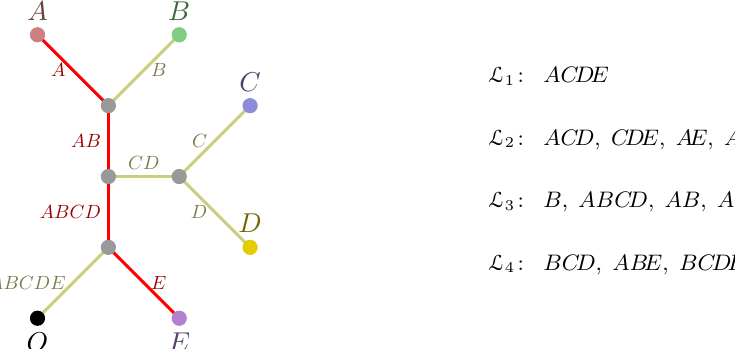
Figure 6. An example of a simple tree with a choice of min-cut for ACDE , showing the different implications of lemma 4 and lemma 12. The min-cut for ACDE is specified by its set of cut edges C ∗ , shown in red in the figure. We have labeled each edge e in the graph by the corresponding ACDE polychromatic index I ( e ) . The right panel shows the full list of subsystems whose min-cuts are fixed by C ∗ according to lemma 12, each one corresponding to a subset of C ∗ ACDE